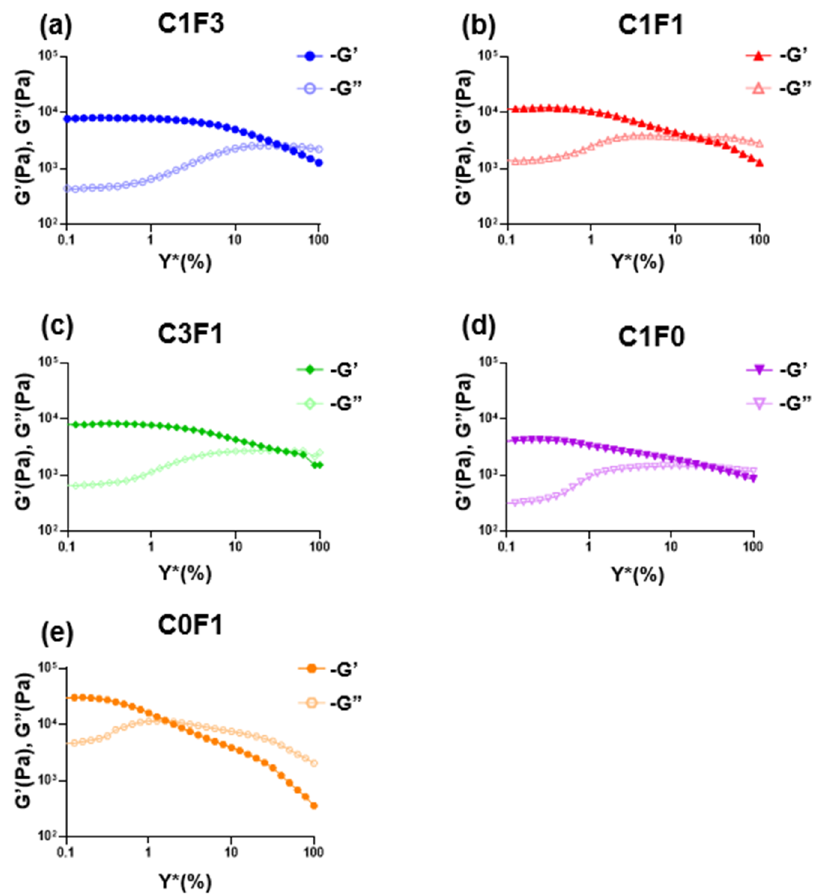
Figure 8. The rheological measurements of the fabricated hydrogel composites represented in loss modulus G″ and storage modulus G′ with respect to amplitude for different fabricated hydrogel samples, namely ( a ) C1F3, ( b ) C1F1, ( c ) C3F1, ( d ) C1F0, and ( e ) C0F1, with CNC and CNF in variable compositions. Table 3. Calculated linear viscoelastic region (LVER), flow point, and flow transition index of fabri- cated hydrogel compositions.